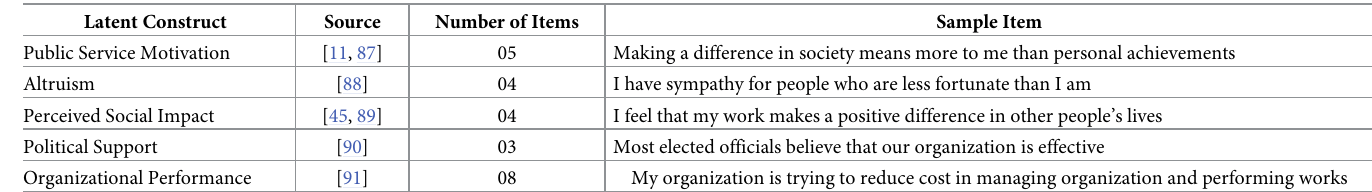
Table 1. Measures.